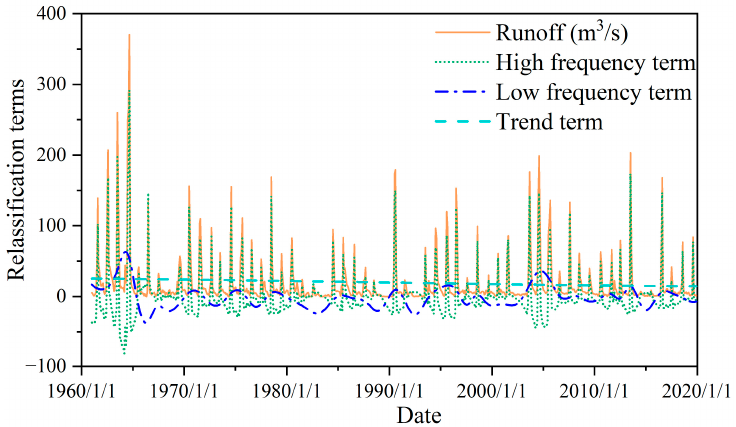
Figure 19. The reclassified IMF terms and original runoff data for Beiwang station.